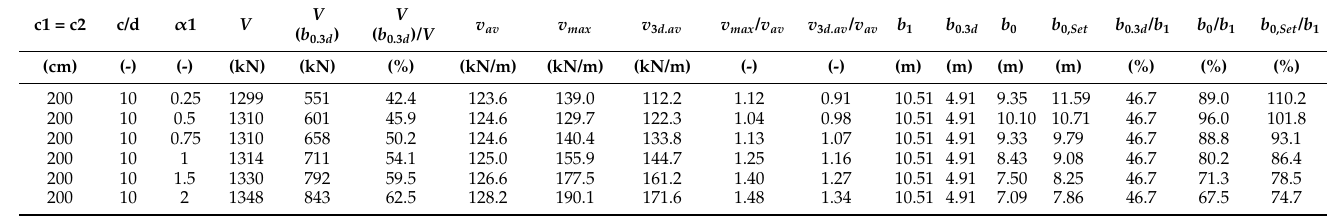
Table A8. Analysis of the shear force distribution in the control perimeter 2 d with 200 cm shear cap size.